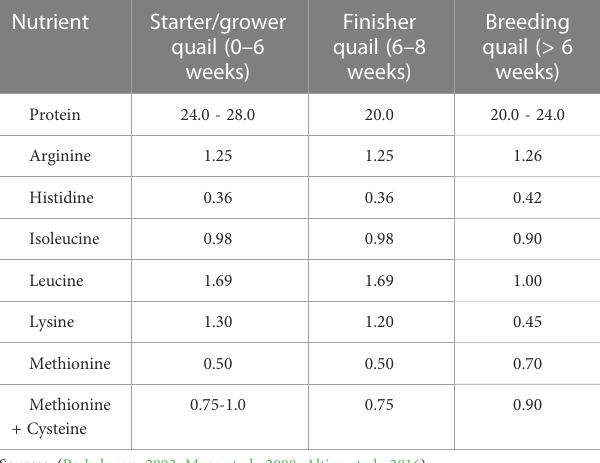
TABLE 3 Protein and amino acid requirements of quails (% DM, unless otherwise stated).